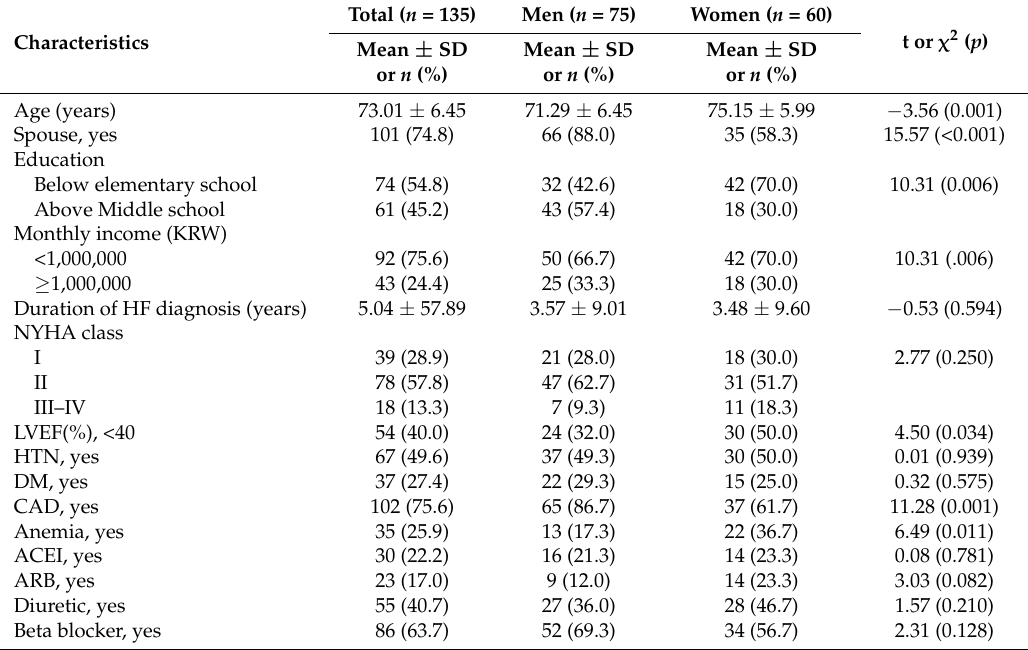
Table 1. Gender differences in socio-demographic and clinical characteristics.